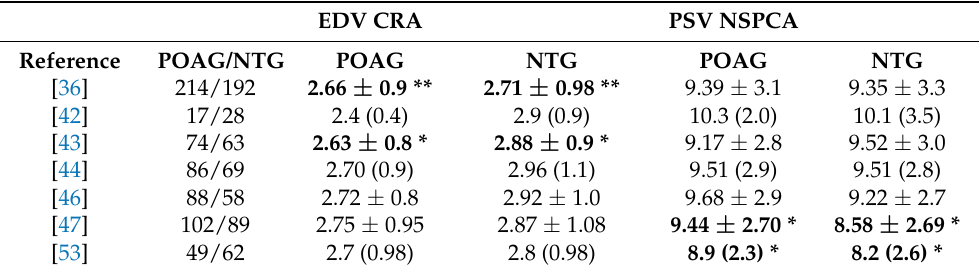
Table 3. Comparison of EDV in the CRA and PSV in the NSPCAs in POAG vs. NTG